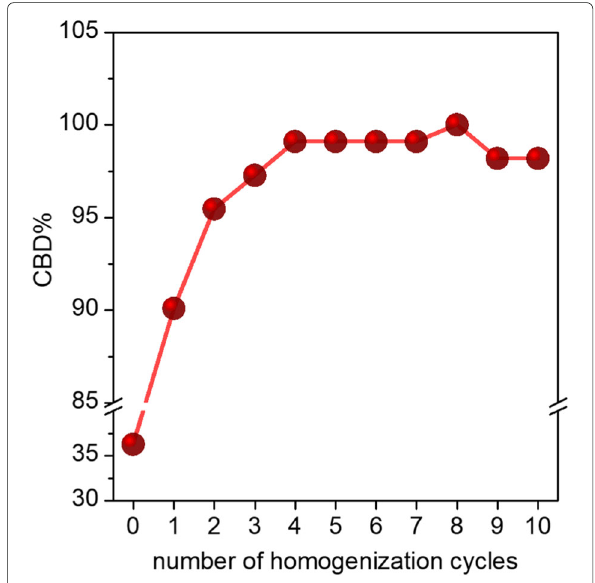
Fig. 4 Variation of CBD% in nanoemulsion as a function of the number of homogenization cycles for a CD CBD